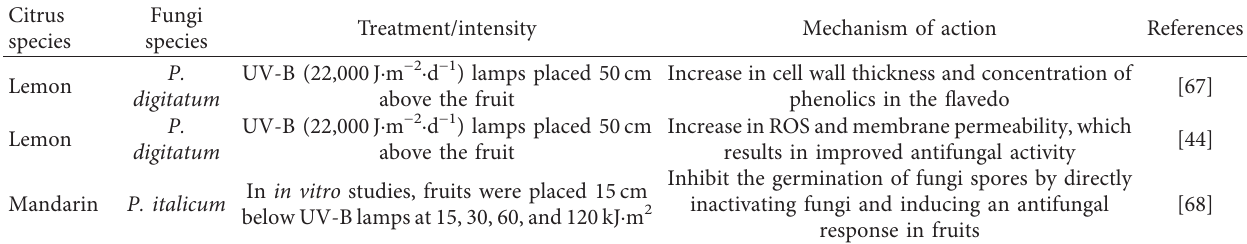
Table 2: Effects of UV-B irradiation on the postharvest rotting caused by P. italicum and P. digitatum . Citrus